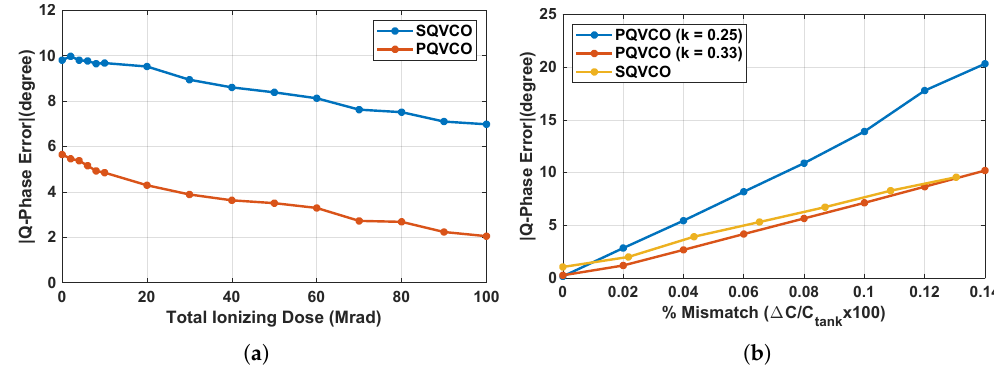
Figure 10. ( a ) Variations of Q-phase error measured with respect to TID of 100 Mrad (SiO 2 ), ( b ) simu- lated Q-phase error for the SQVCO and PQVCO with respect to different relative mismatch in C tank . The phase noise characteristics of the PQVCO and the SQVCO measured at